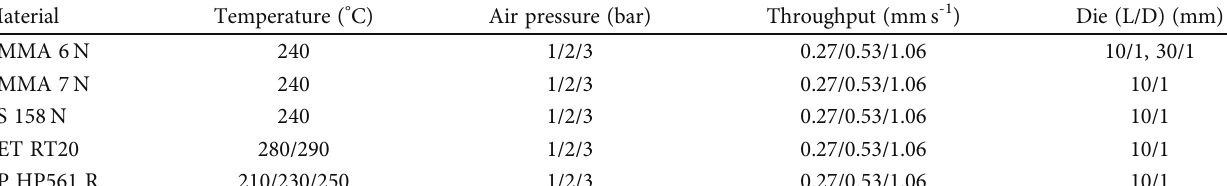
Table 1: Relevant process parameters for the capillary rheometer samples.